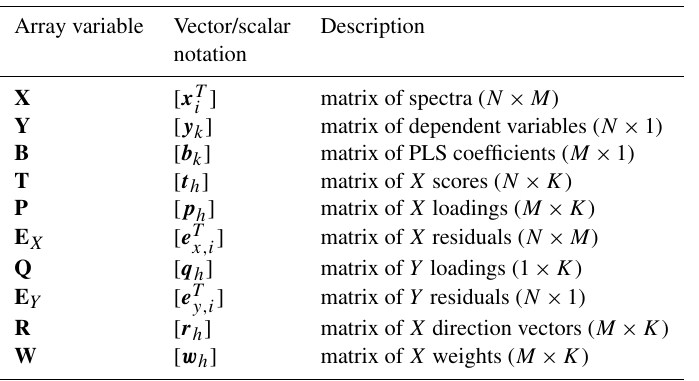
Table A2. Arrays and